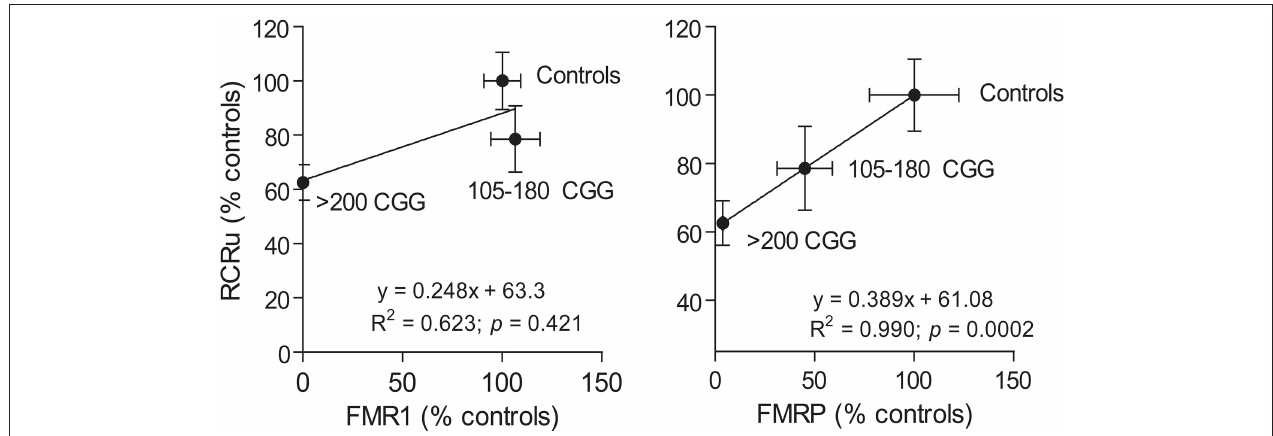
FIGURE 4 | Correlation between mitochondrial outcomes and FMRP or FMR1 expression levels. The correlation between FMRP and FMR1 expression with a mitochondrial outcome (i.e., coupling between ATP synthesis and electron transfer or RCRu) was carried out using human primary dermal from controls, premutation carriers (105–180 CGG), and full mutation carriers ( > 200 CGG repeats). RCRu, FMR1 , and FMRP levels were expressed as percentage of control values. Data are shown as mean ± SEM for controls, permutation, and full mutation